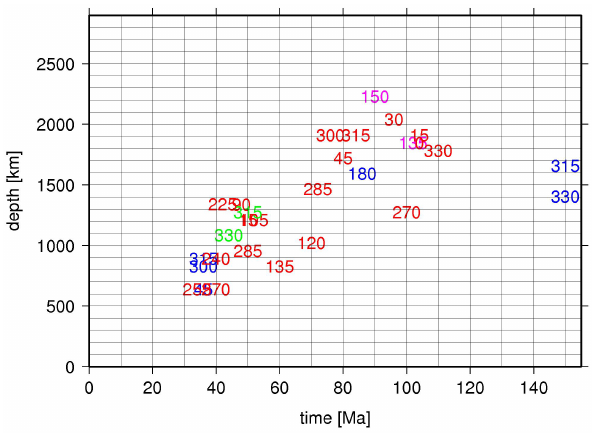
Fig. 9. Depth vs. time interpreted by matching specific features of tomography: If at a given cross section (indicated by the number plotted) a specific slab feature can be matched in the geodynamic model st12den-2 and the tomography model, the time of subduc- tion is determined from the slab tracers in the geodynamic model, and plotted against the corresponding depth determined from the tomography model. Colors indicate the kind of feature: red – lower end of slab; violet – upper end of slab, if another slab is follow- ing; blue – upper end of slab, if no other slab is following; green – mid-slab feature, the characteristic slab bend beneath East